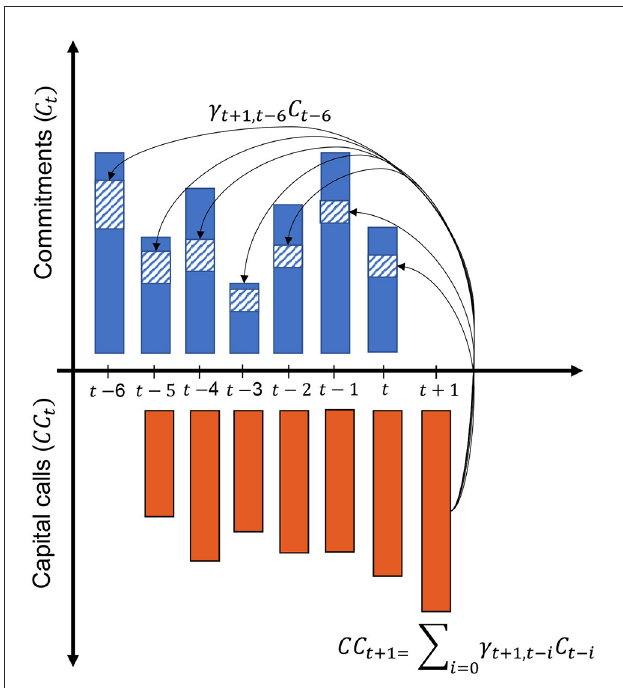
FIGURE1 Each capital call is a fraction of the previous commitments. This fraction diminishes with time such that γ t + 1, t − i ≈ 0 when i ≥ 6